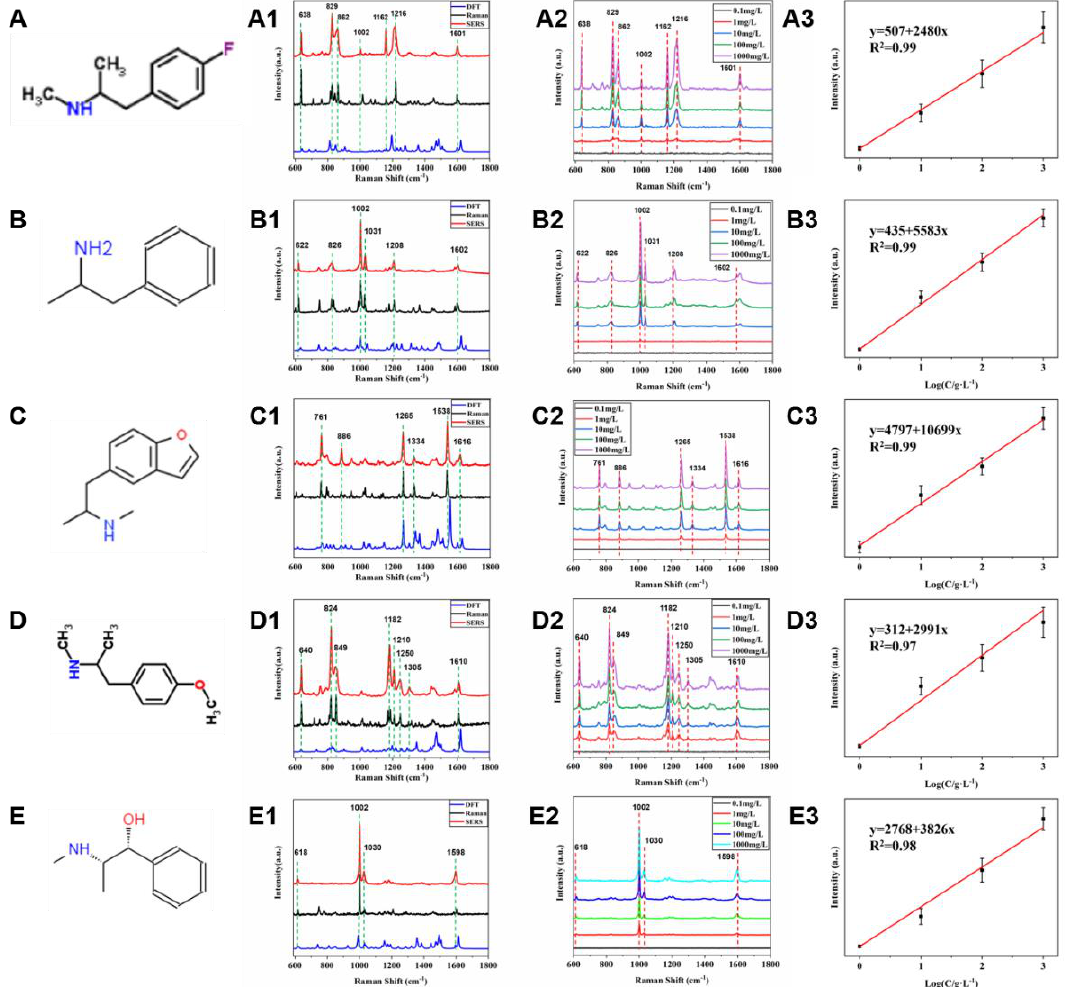
Figure 6. ( A – E ) Molecular structures of 5 kinds of amphetamine analogs, ( A1 – E1 ) Raman spectrum (black), DFT (blue) and SERS spectrum (red) of 5 kinds of amphetamine analogs powders, ( A2 – E2 ) SERS spectra of 5 kinds of amphetamine analogs at different concentrations. ( A3 – E3 ) The calibration curves of 5 kinds of amphetamine analogs.